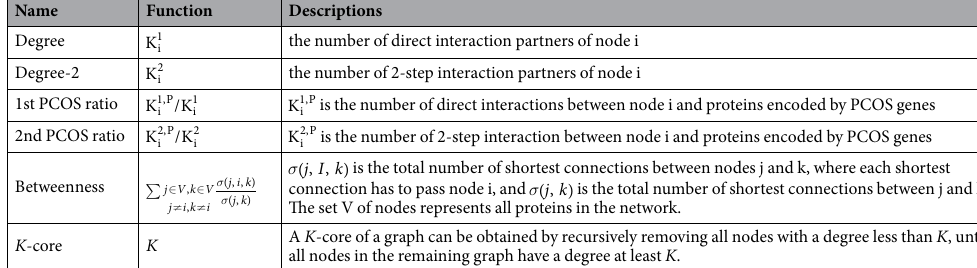
Table 4. Formal Representation of Graph Measures. Functions are the definitions of the topological features. Descriptions give explanations for symbols in the